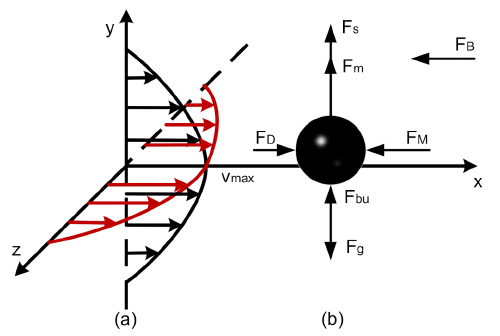
Figure 1. ( a ) Laminar velocity distribution: the red and black arrows indicate the velocity distribution of oil in the width and height directions of the channel, respectively, while V max is the maximum velocity at the center of the channel; ( b ) various forces acting on particles in the laminar flow field (the parameters are defined in the